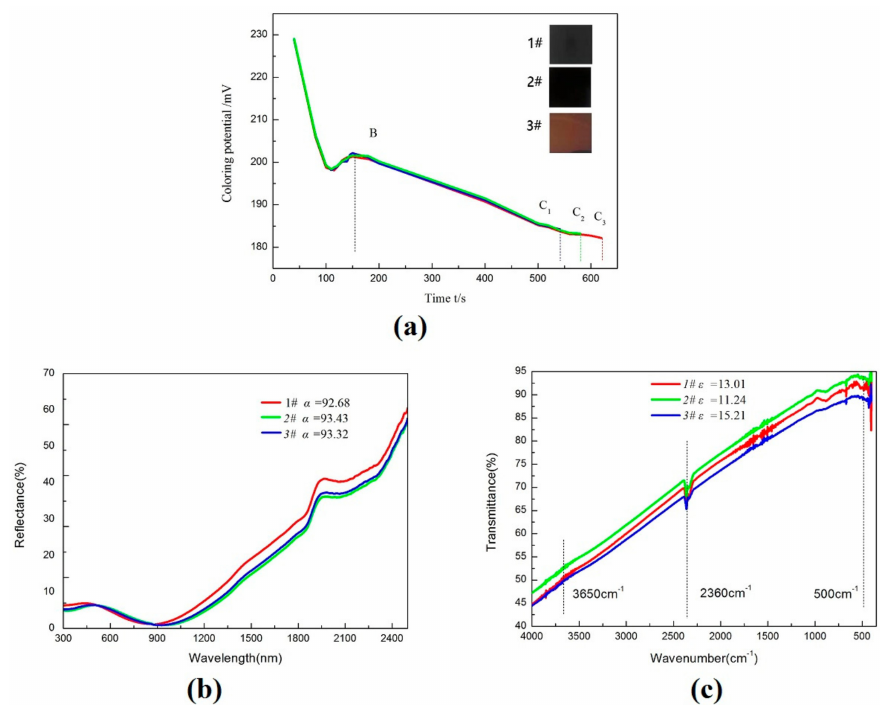
Figure 2. ( a ) Coloring potential-time curves, ( b ) UV-Vis-NIR spectra of the coatings by di ff erent samples, ( c ) FTIR spectra of the coatings by di ff erent